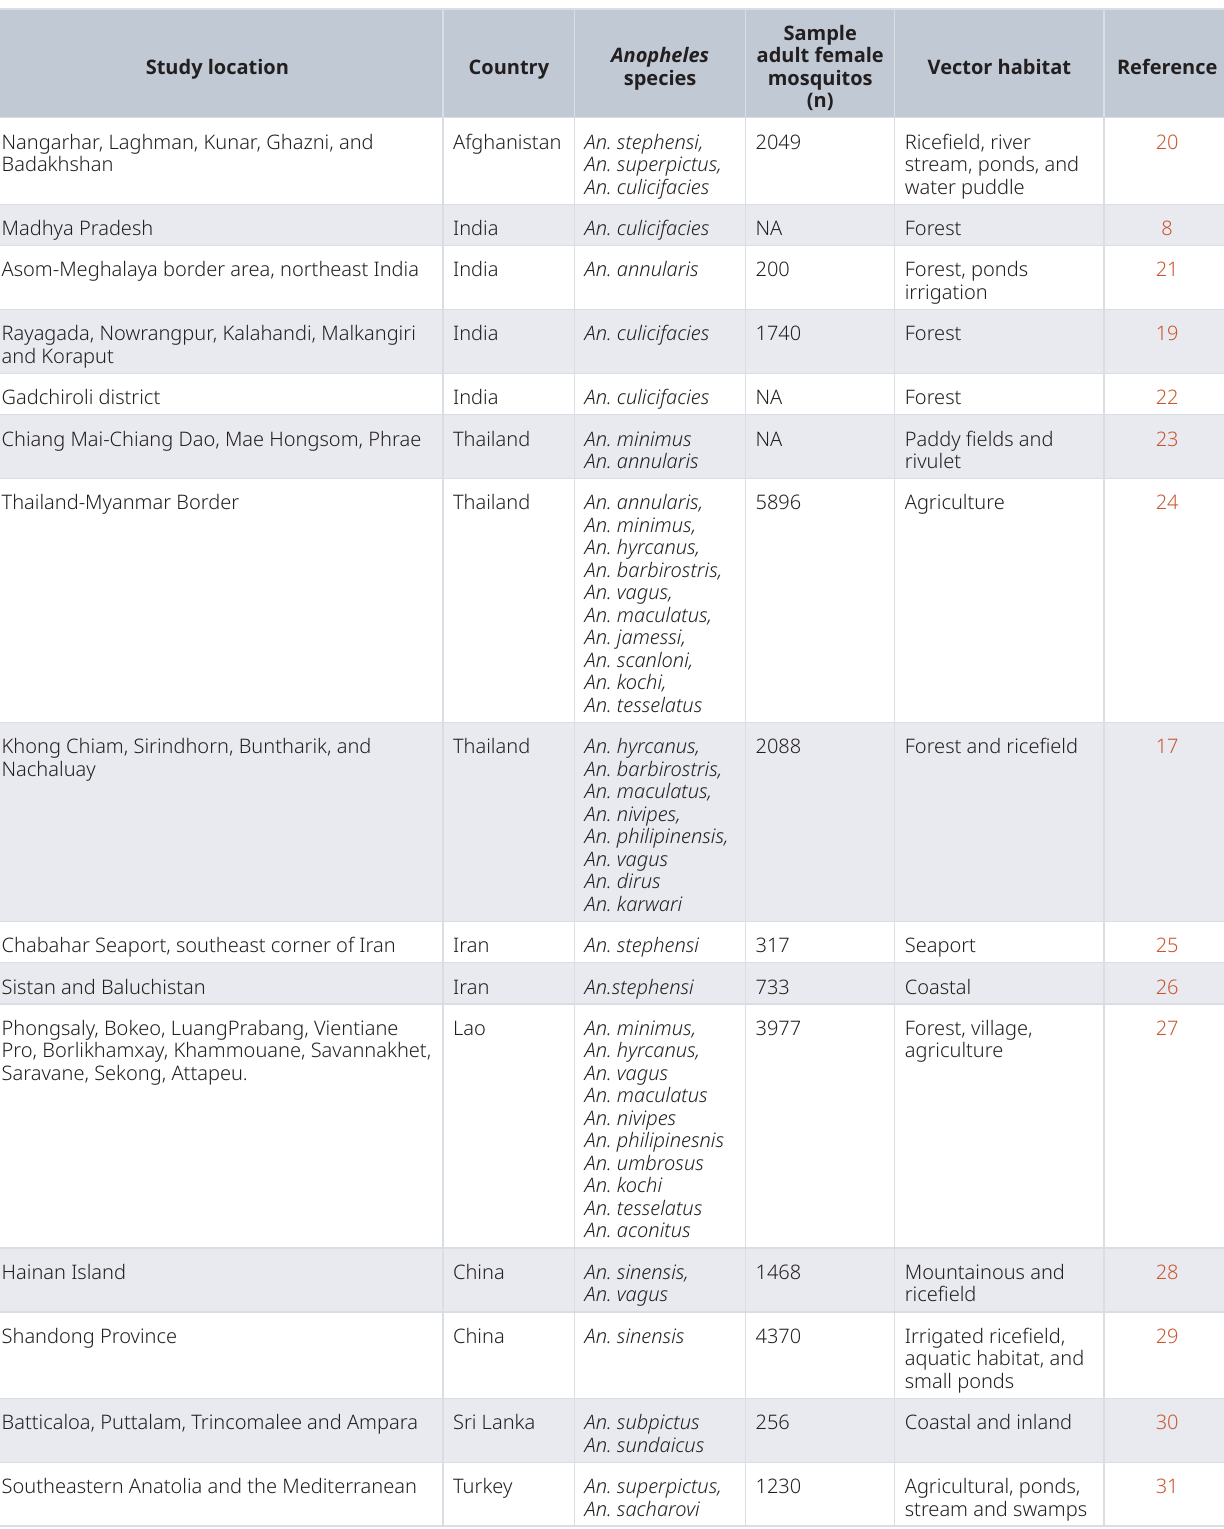
Table 2. Mosquito species and their types of habitat.